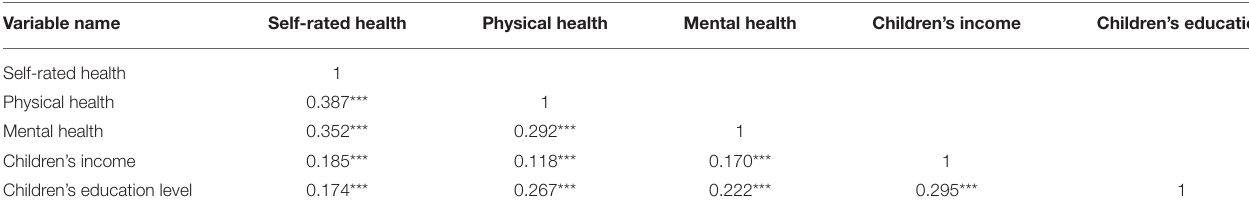
TABLE 2 | Correlation analysis between main